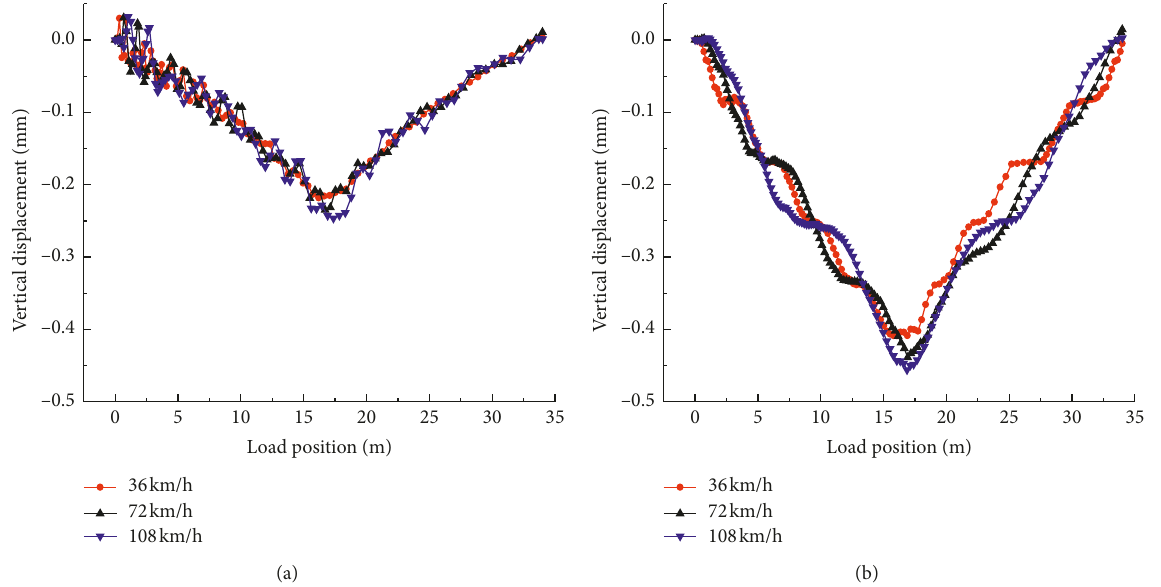
Figure 11: Comparison of vertical displacement on the surface of the bridge deck pavement of both models. (a) CWBG bridge. (b) CSWBG bridge.